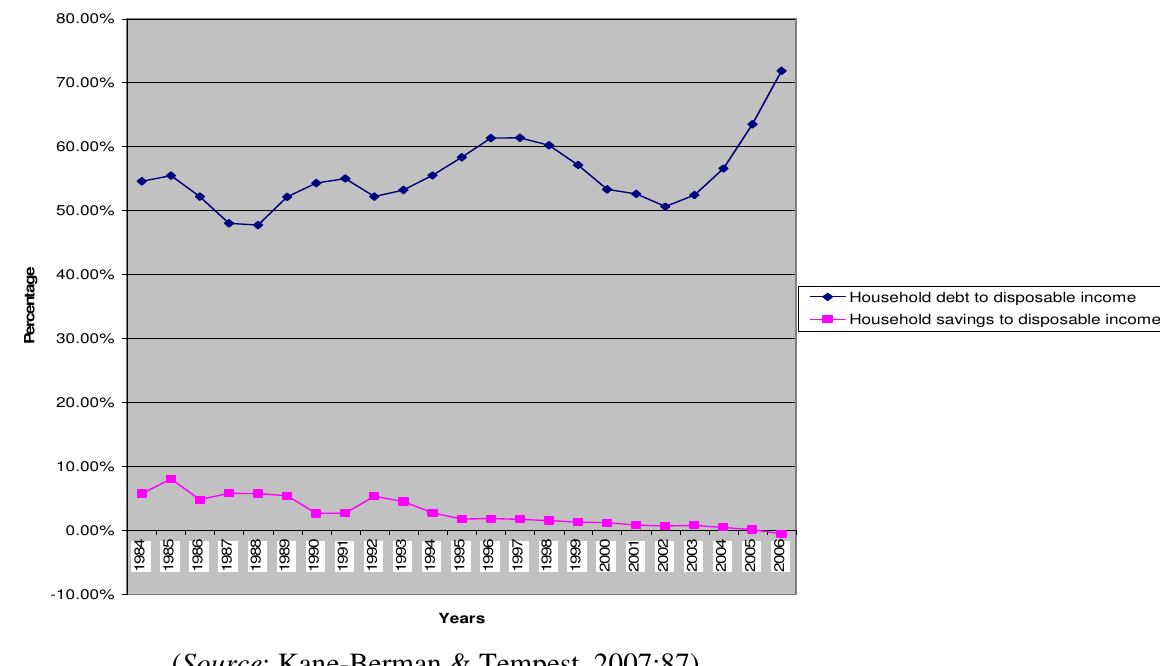
Figure 1: Household debt and household savings as a percentage of personal disposable income